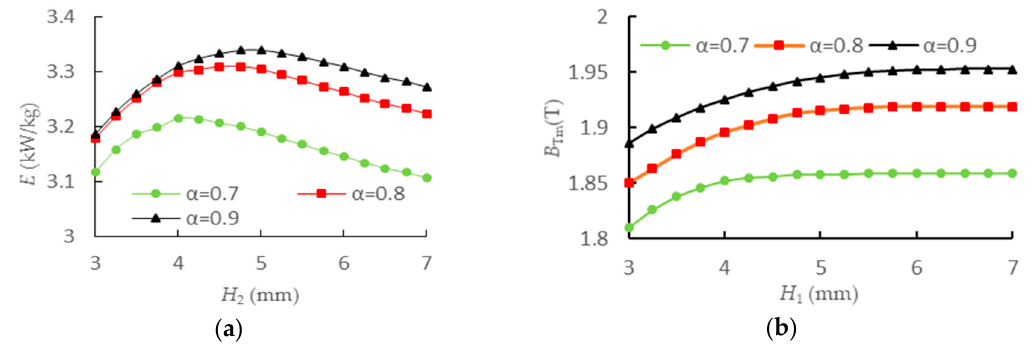
Figure 4. ( a ) Changes of power density with the thickness of the rotor yoke; ( b ) Changes of the magnetic density at the motor teeth with the thickness of the rotor yoke.